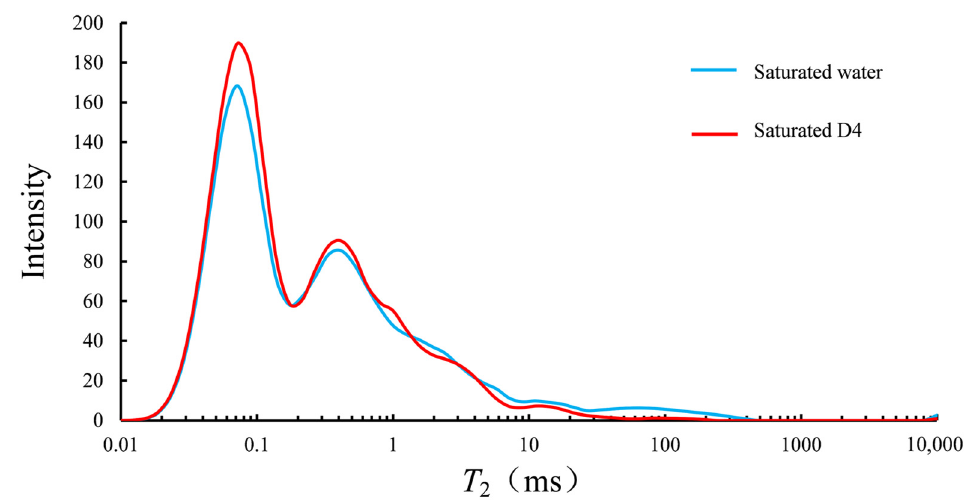
Figure 6. T 2 spectrums of shale saturated with water and D4.